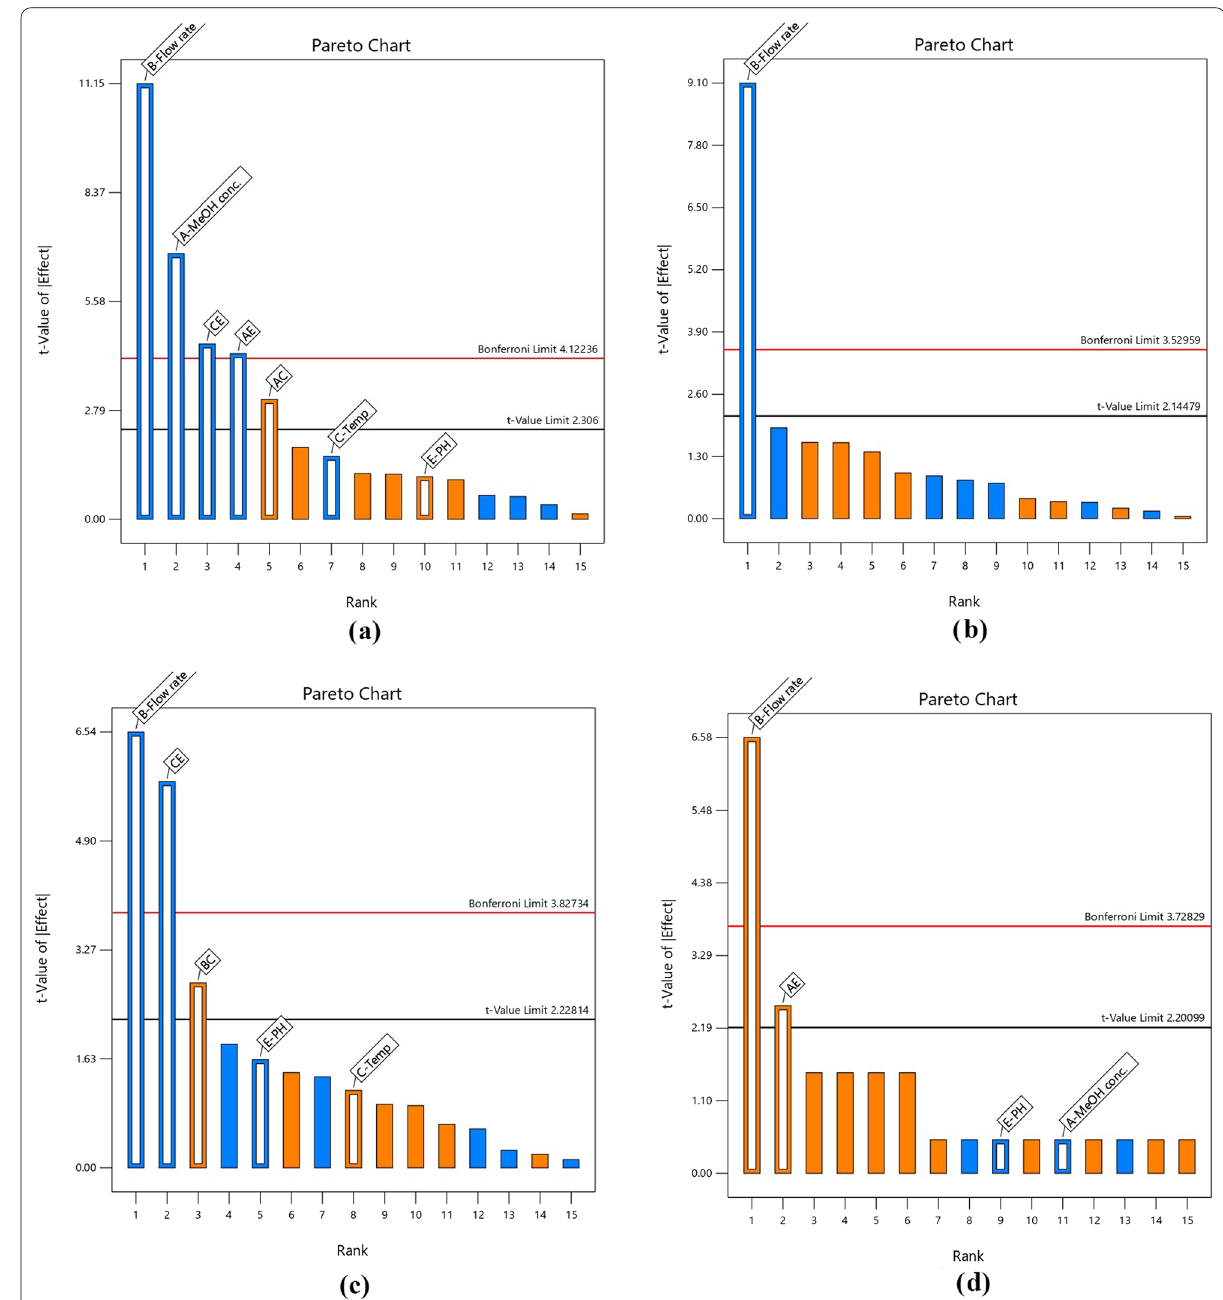
Fig. 1 Pareto charts showing the impact of critical factors on the analytical responses (RT, PA, TP, and TF). RT ( 1a ), PA ( 1b ), TP ( 1c ), and TF ( 1d